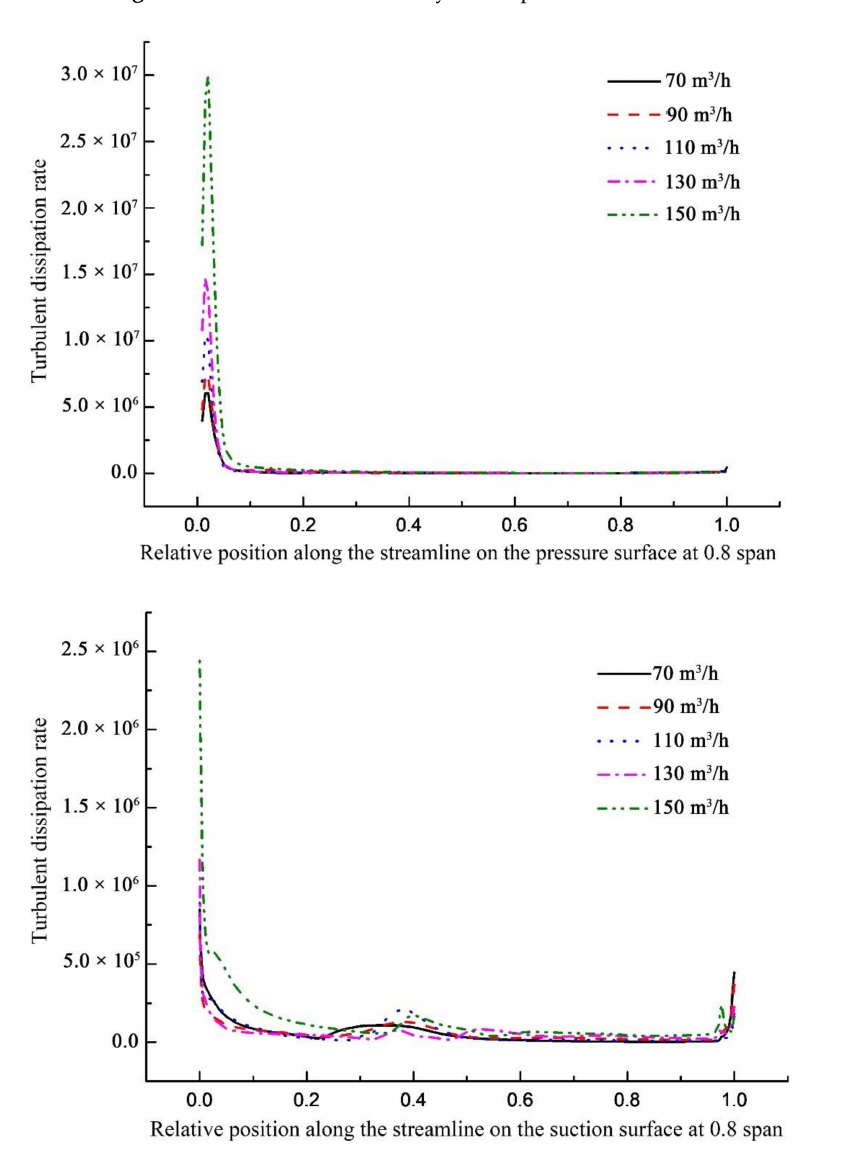
Figure 13. Contour of the velocity at 0.8 span.